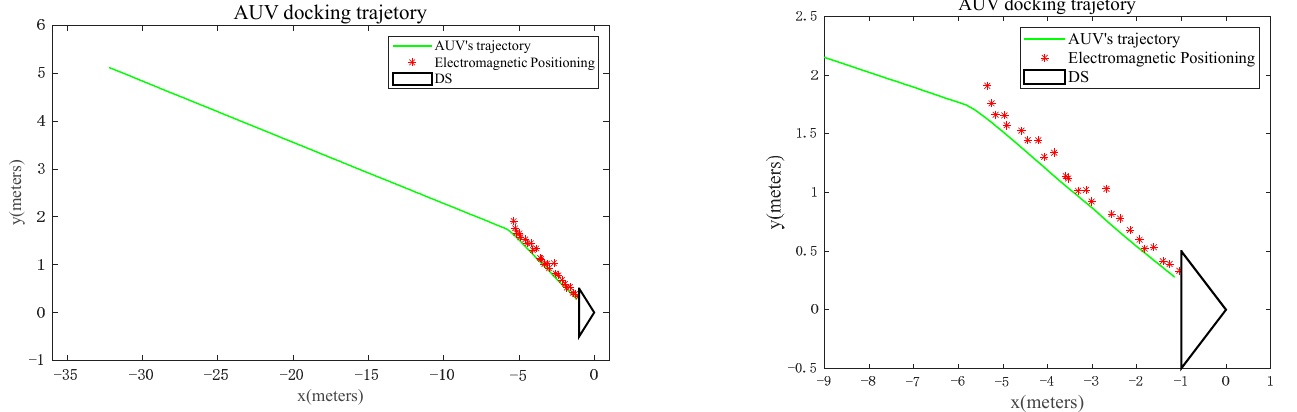
Figure 19. AUV trajectory of successful docking (green: calculated by the velocity and yaw angle; red: electromagnetic positioning).